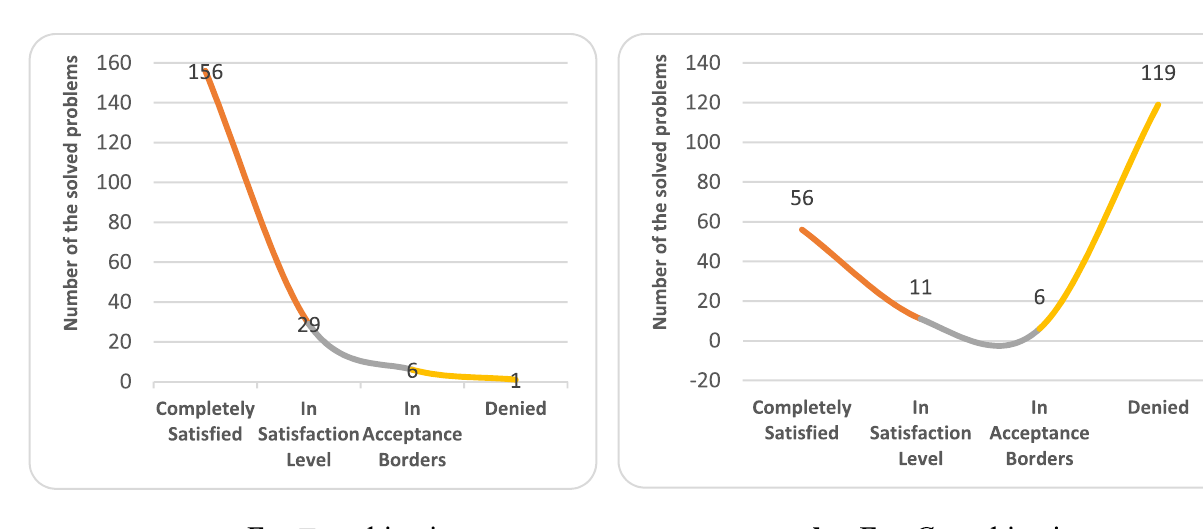
Fig.7 The satisfaction status based on ∑ C j and C